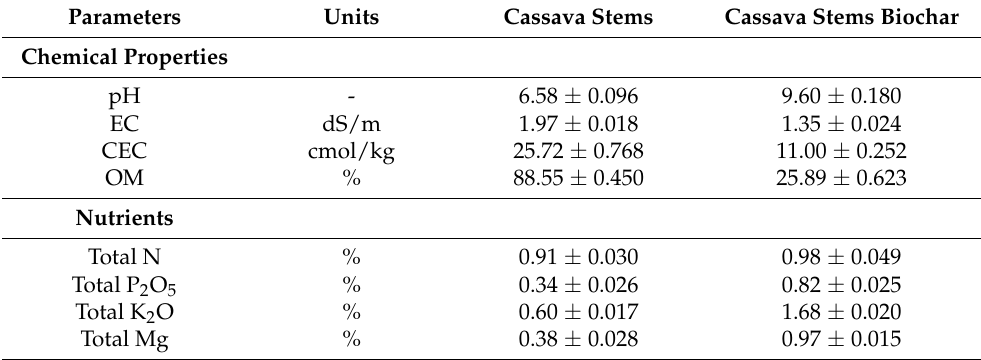
Table 2. Chemical properties of cassava stems and cassava stem